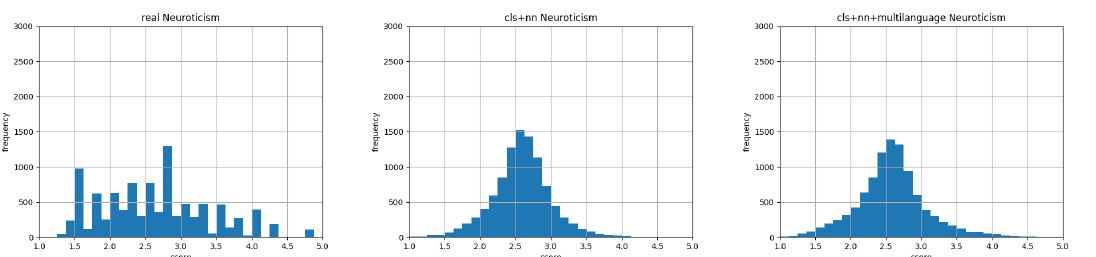
Figure 14. Agreeableness: Histograms representing data distribution of gold standard on the left, our English model result in the middle, and our multilingual model result on the right.